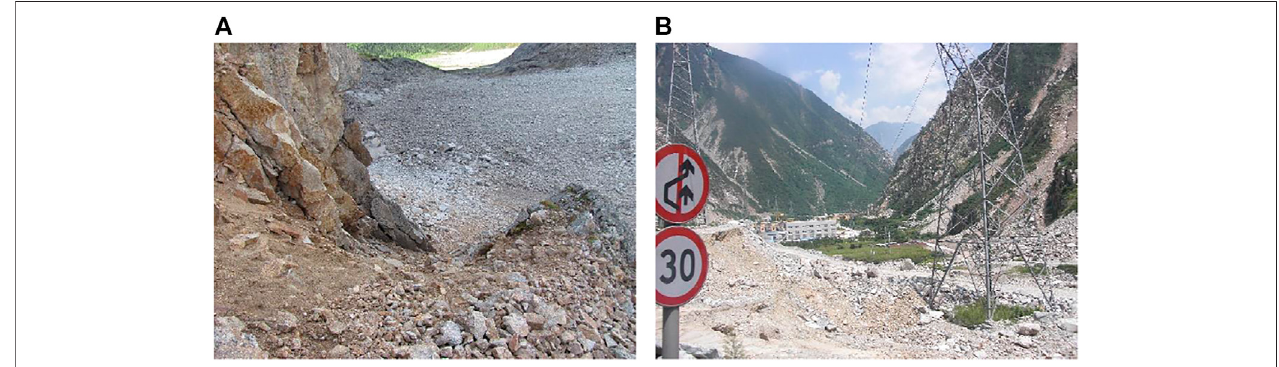
FIGURE 1 | Soil erosion phenomenon in the study area (Taken in